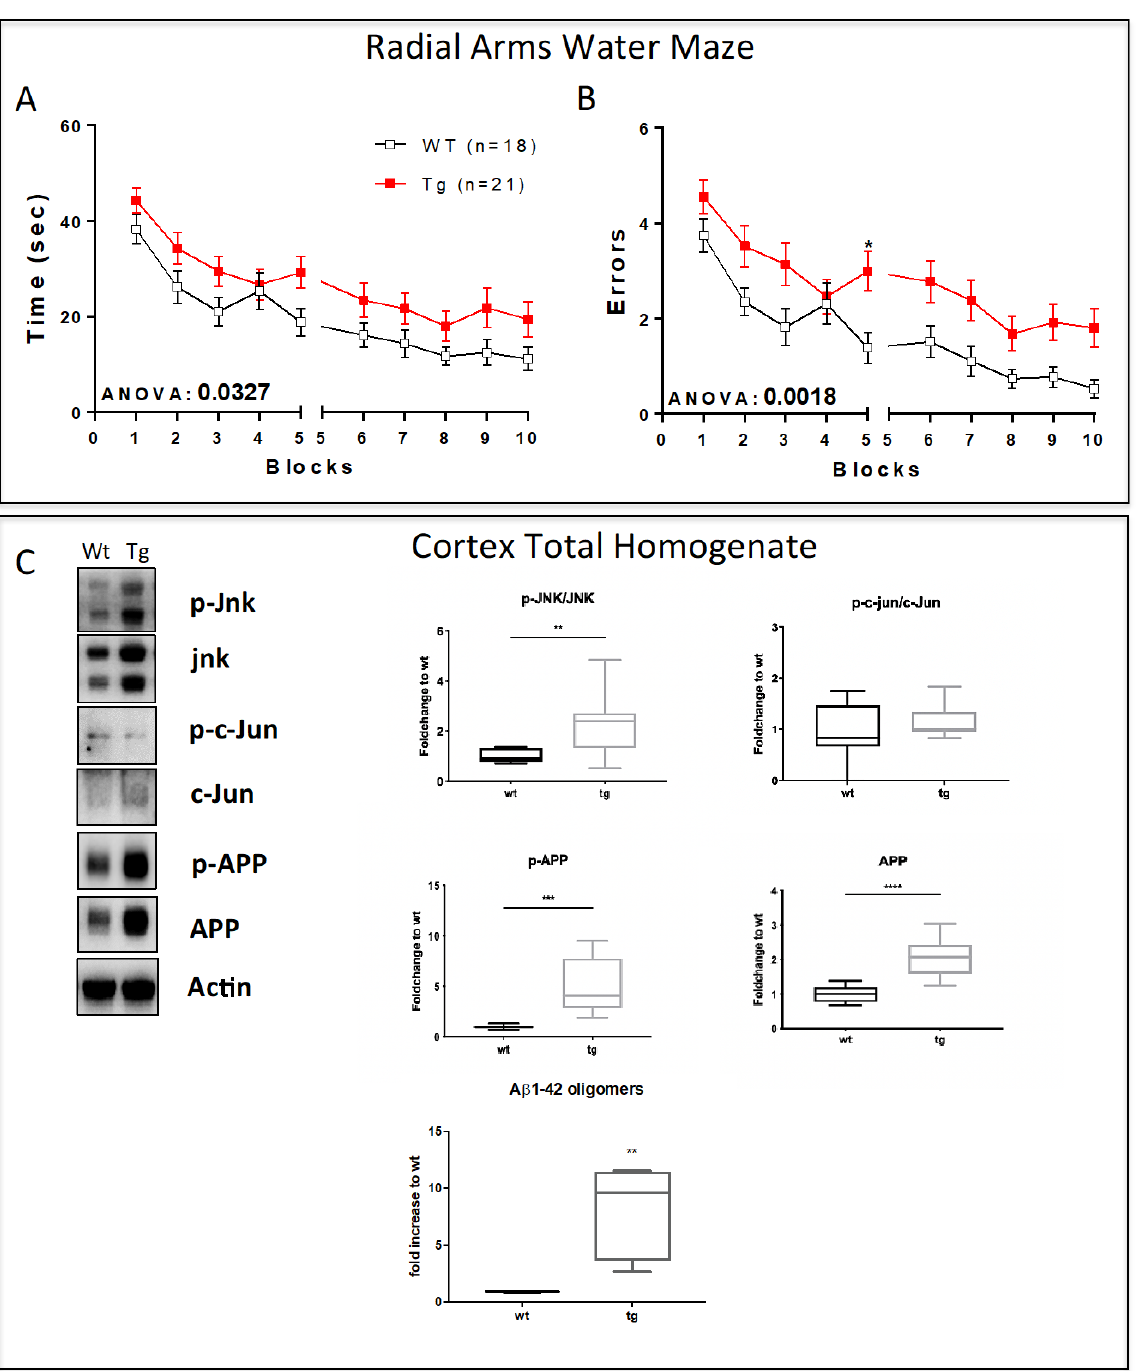
Figure 2. Activation of JNK signaling pathway correlates with cognitive impairment in 3.5-month-old 5xFAD mice. ( A ) Time and ( B ) number of errors to find the submerged escape platform demonstrate an initial cognitive impairment in 3.5-month-old tg-5xFAD mice. ( C ) Representative Western blots and relative quantifications of cortical total homogenate show higher levels of p-JNK/JNK ratio, p-APP, and APP but no statistical differences in p-c-Jun/c-Jun ratio in 5xFAD vs. wt mice. Elisa analysis shows an 8.6 fold increase in Aβ1 -42 oligomers in cortical total homogenate in 5xFAD mice. Genotypes are compared using t -tests. Statistical significance: * p < 0.05, ** p < 0.01, *** p < 0.001, **** p < 0.0001. Data are expressed as mean ± SEM.